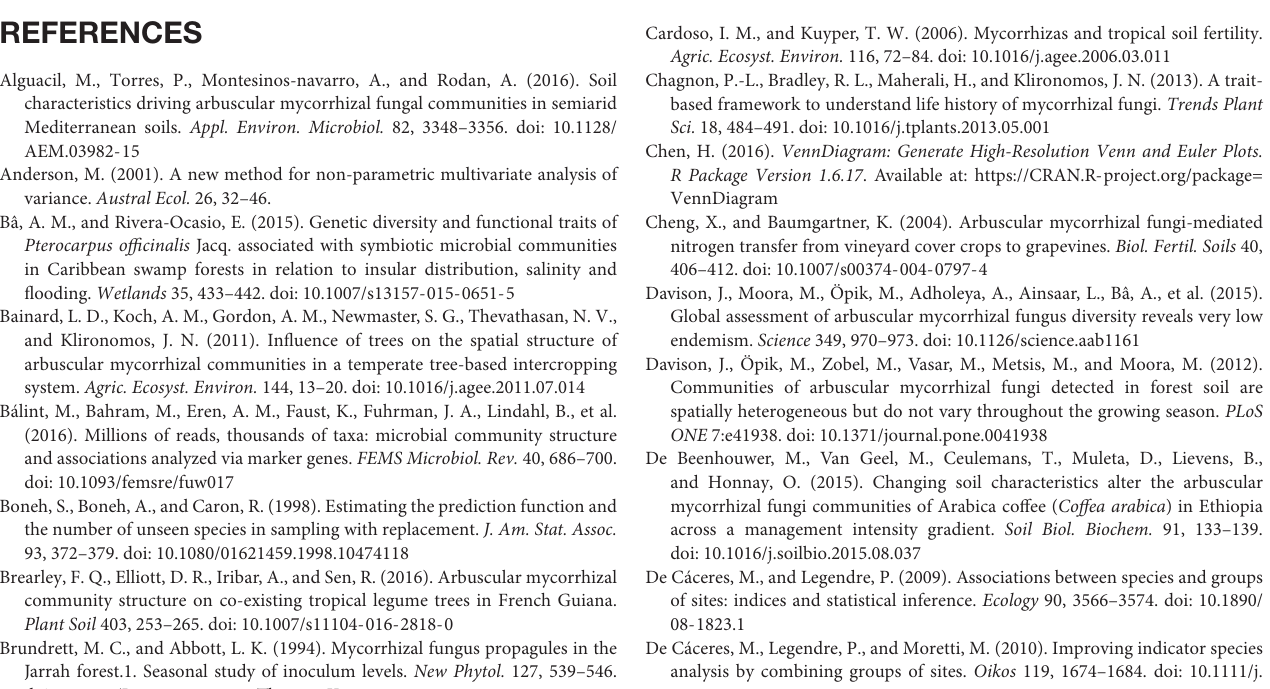
FIGURE S1 | Map of Guadeloupe with the two sampling forest sites. FIGURE S2 | Non-metric multidimensional scaling (NMDS) ordination of Pterocarpus and taro root-associated AM fungal communities in Grande Ravine and Belle Plaine forest sites. Different colors represented the three types of